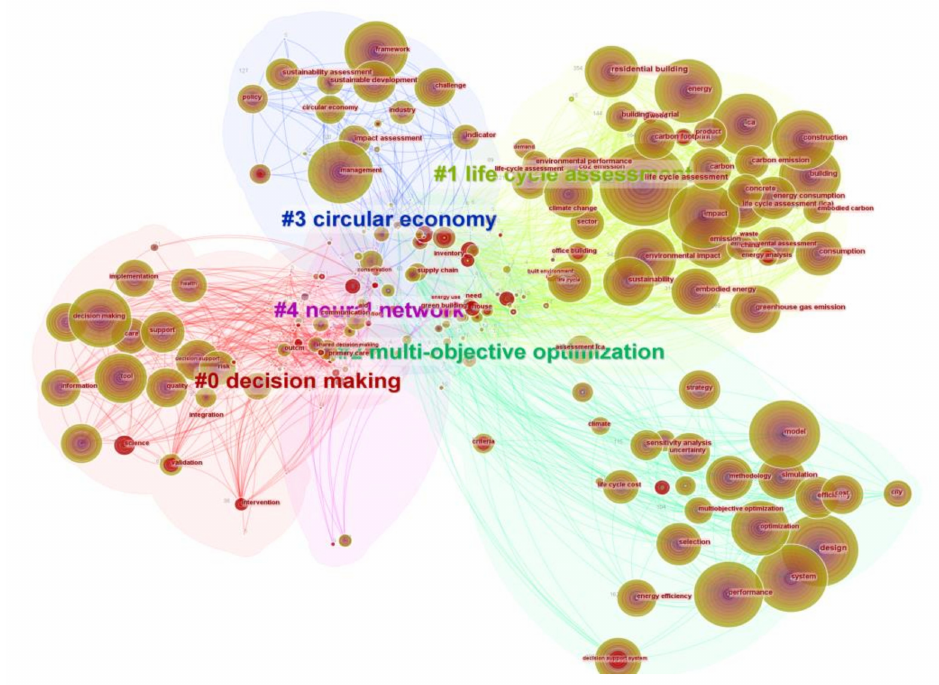
Figure 2. Co-occurrence diagram analysis of keywords related to building climate responsive